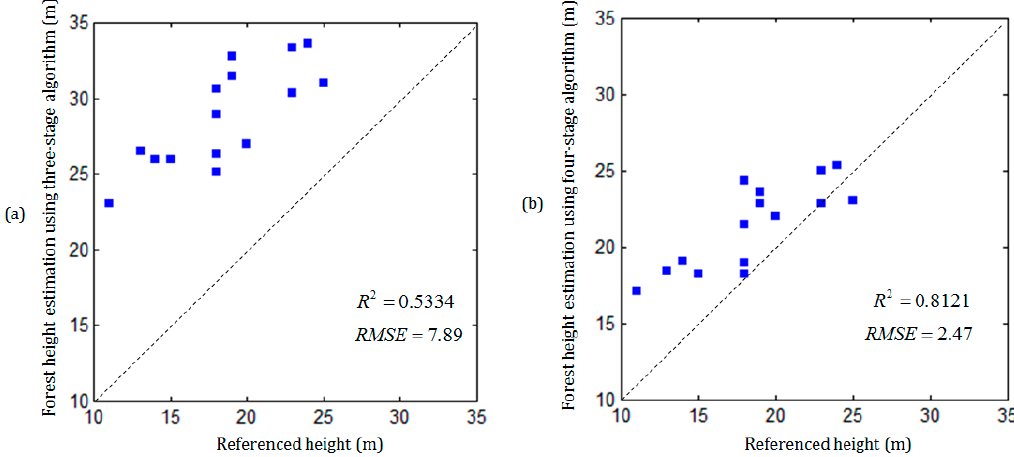
Figure 15. Comparison between LiDAR measurements and forest height inversion from three-stage and four-stage algorithms.